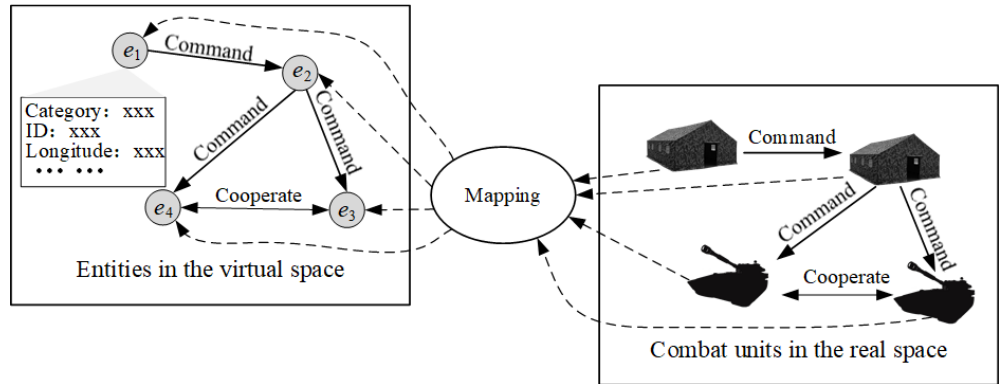
Figure 2. Entity oriented mapping from the real space to virtual